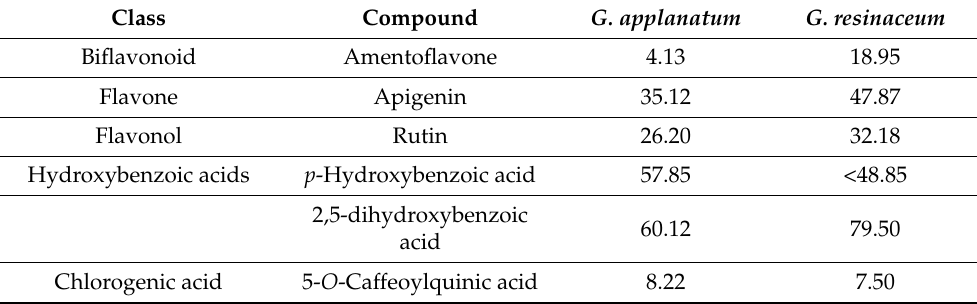
Table 1. Determined concentrations of selected phenolic compounds using LC–MS/MS method in examined CHCl 3 extracts of G. applanatum and G. resinaceum ( µ g/g